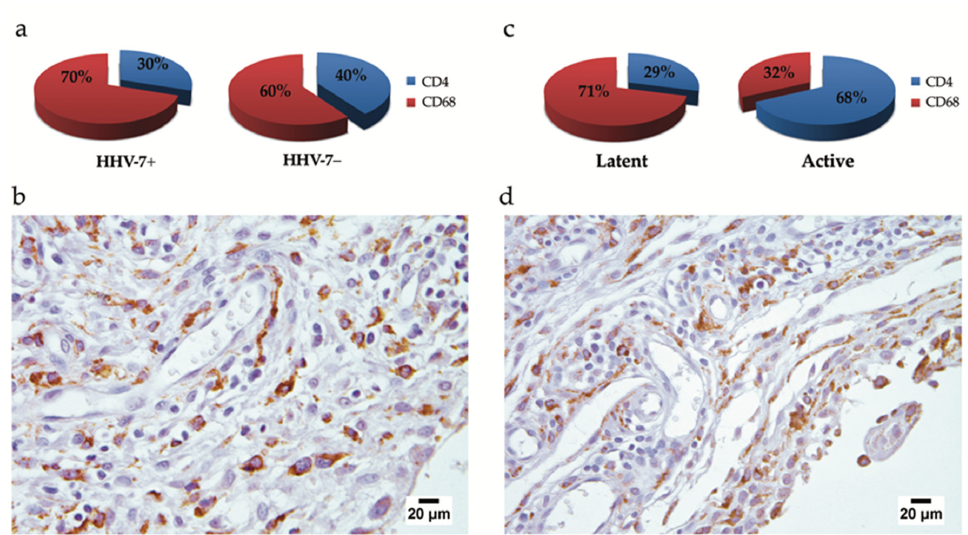
Figure 5. Comparison of the distribution of synovial CD68- and CD4-positive inflammatory cells by the use of statistics ( a , c ), and the microscopical assessment of CD68-positive cells ( b , d ). ( a ) The distribution of CD68- and CD4-positive cells in both HHV-7 PCR + and HHV-7 PCR − groups: CD68-positive cells constituted almost two-thirds (70%) of inflammatory cells found in HHV-7 PCR − samples, whereas, for CD68- and CD4-positive cells, 60 and 40%, respectively, were more equally distributed in HHV-7 PCR + . ( c ) CD68-positive cells represented a major part (71%) of inflammatory cells in latent HHV-7 infection, whereas these were opposingly distributed in active HHV-7 infection, with 68% and 32% of CD4- and CD68-positive cells, respectively. ( b , d ) CD68 immunohistochemistry; a representative image (( b ), HHV-7 PCR − sample; ( d ), HHV-7 PCR + sample) demonstrating CD68-positive cells decorated by the anti-CD68 antibody and developed brown reaction products in the synoviocytes of lining layer and the macrophages of sublining layer. The immunohistochemical decoration reflects the presence of lysosome-specific proteins involved in sorting in the trans-Golgi region, targeting to lysosomes, and fusion with the plasma